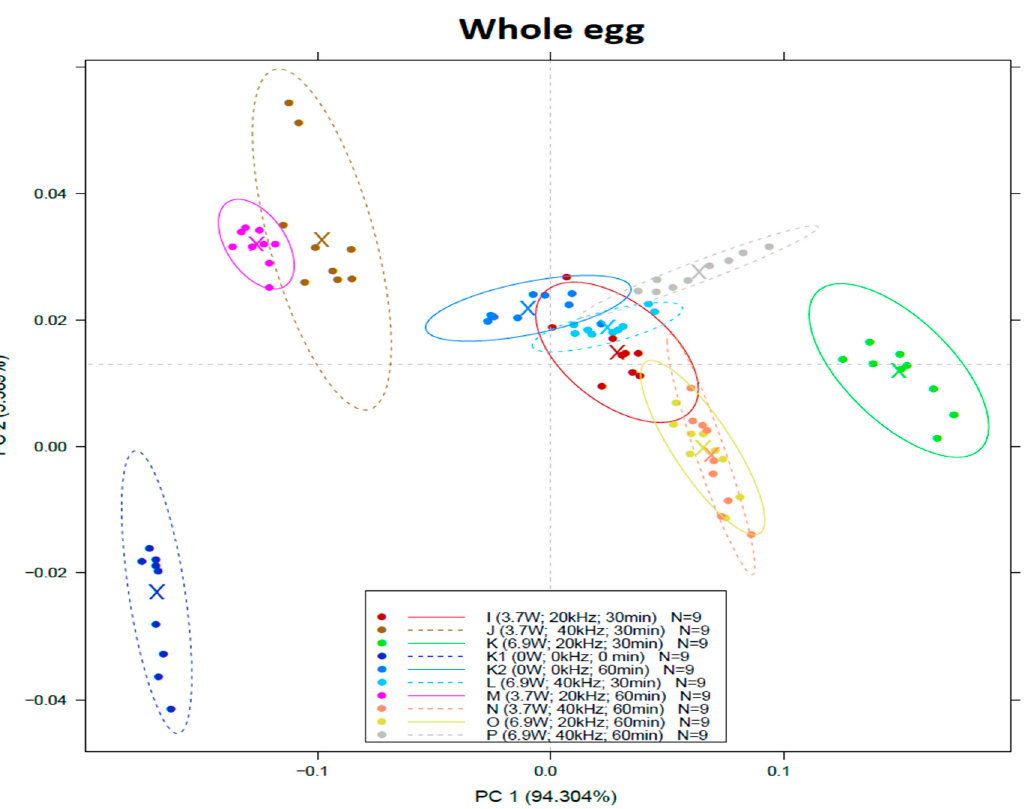
Figure 5. Score plot of principal component analysis (PCA) on spectral data of whole egg within the range of 950–1630 nm.